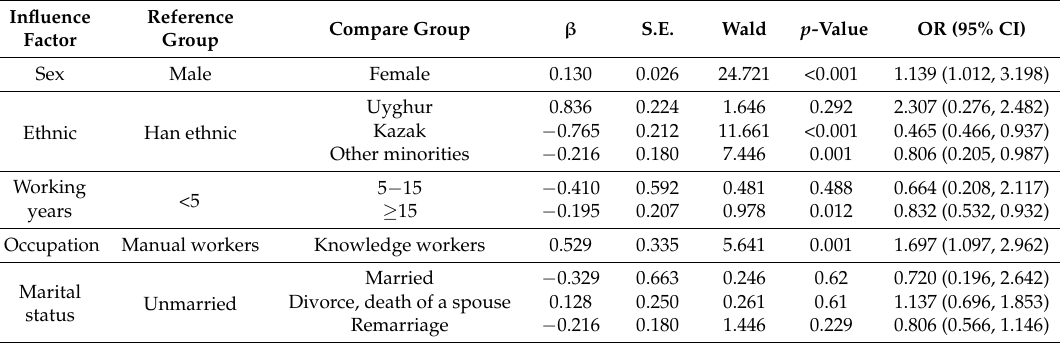
Table 4. Logistic regression analysis of multiple factors influencing mental